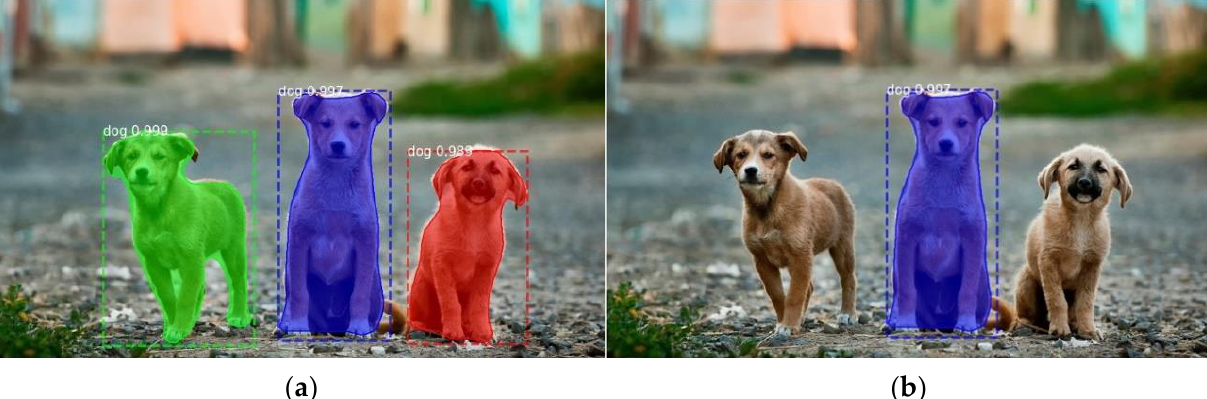
Figure 8. Test sample of the result when passed to the ( a ) Mask R-CNN framework and the result when ( b ) adding the selective model. Table 4. Performance of masking.